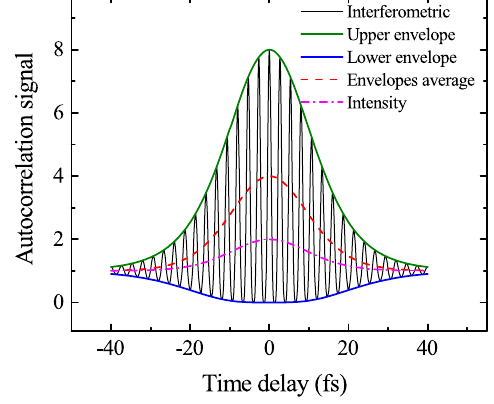
FIG. 11. Second-order autocorrelation of an 800 nm 15 fs